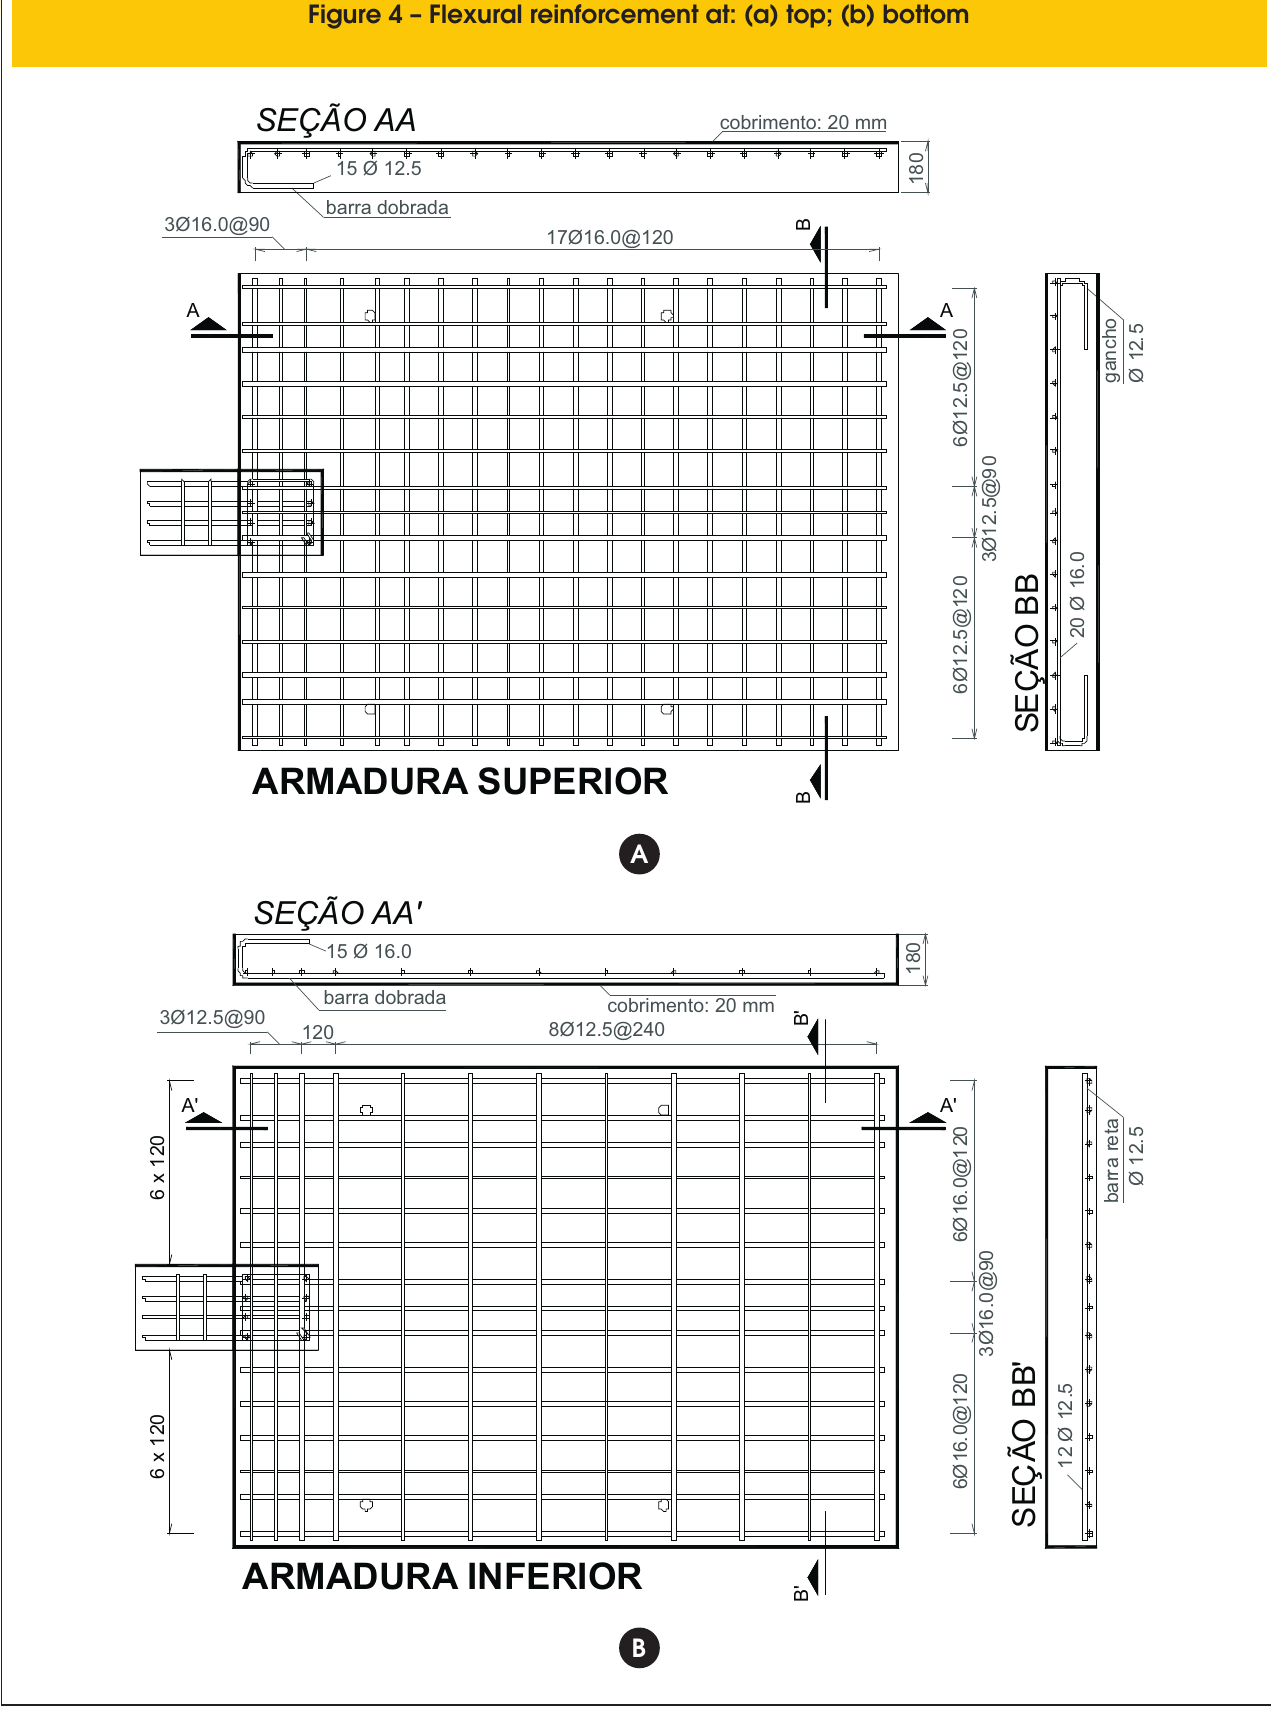
Figure 4 – Flexural reinforcement at: (a) top; (b)